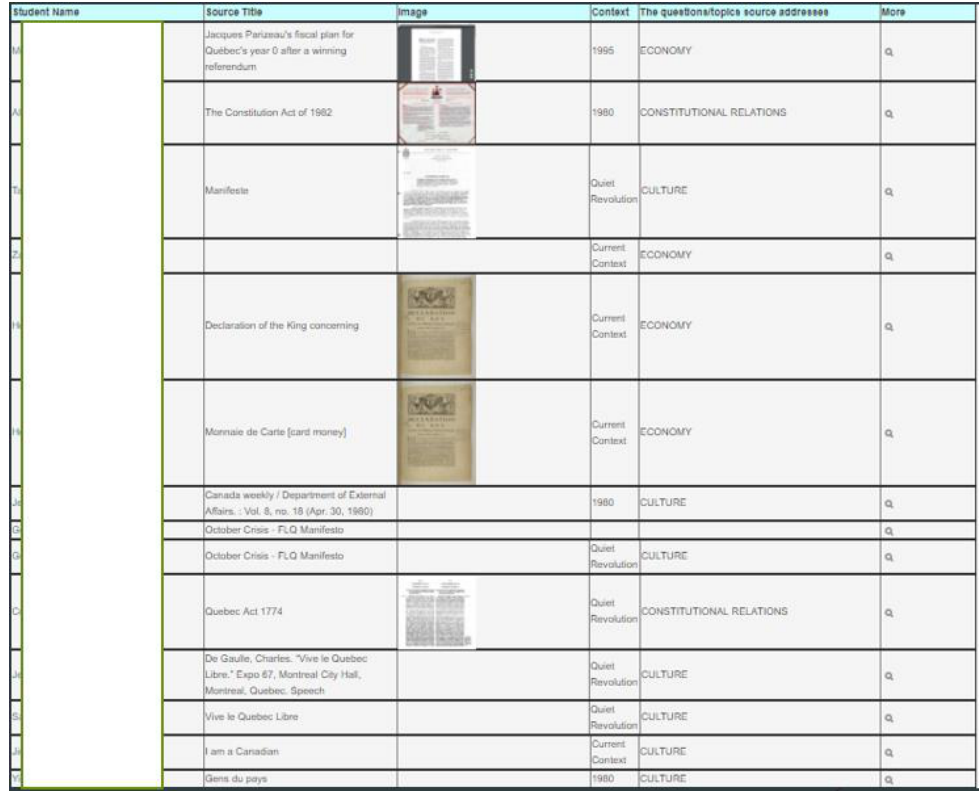
Figure 5. Crowdsourcing and sharing the collected primary sources: List view mode. One of the main advantages of this adaptable Moodle activity is that it allows the data to be displayed in an easy-to-browse and searchable format in a list view mode (Figure 6). This feature becomes essential when preparing for the capstone activity: a class final